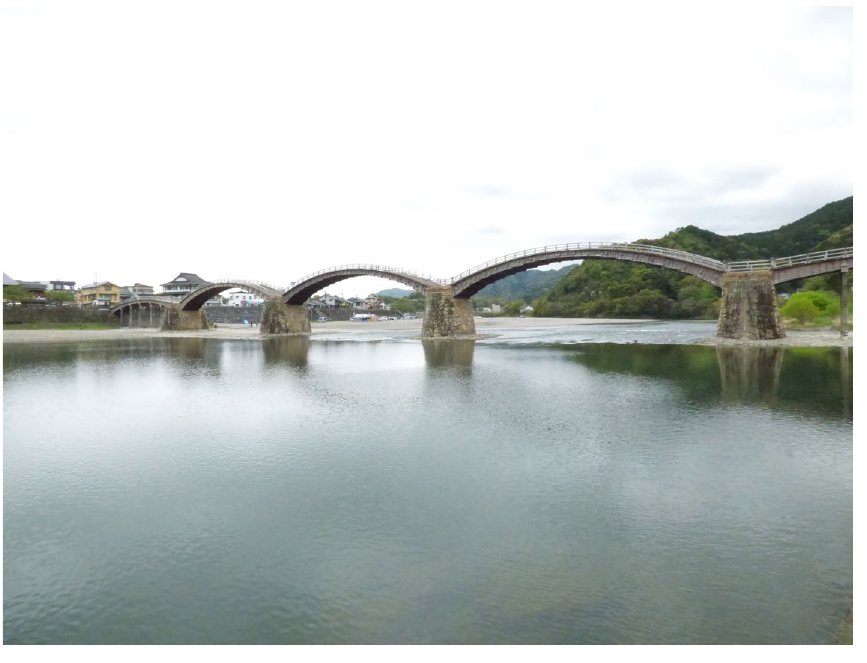
Figure 1. Kintaikyo